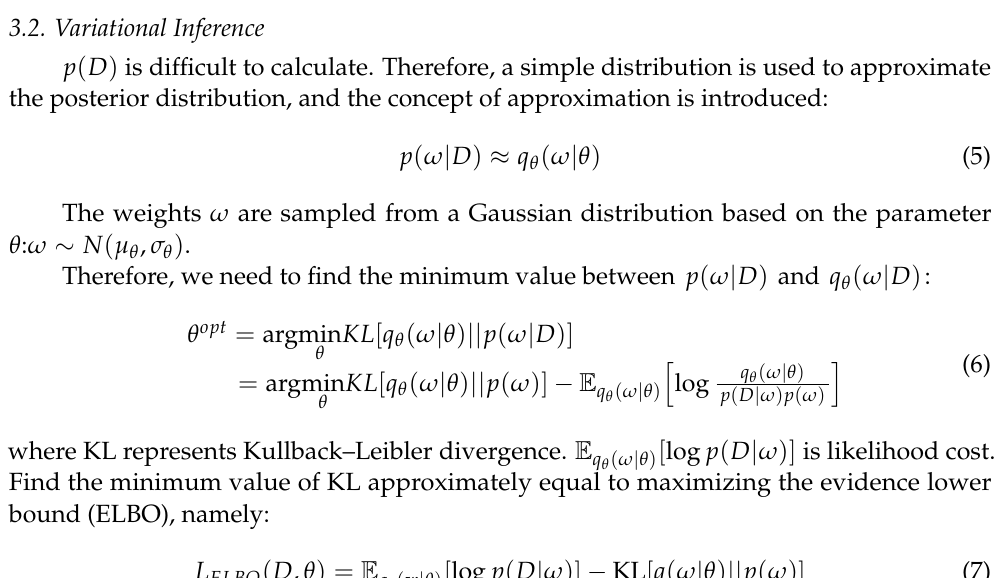
Figure 4. Bayesian parallel deep learning framework.